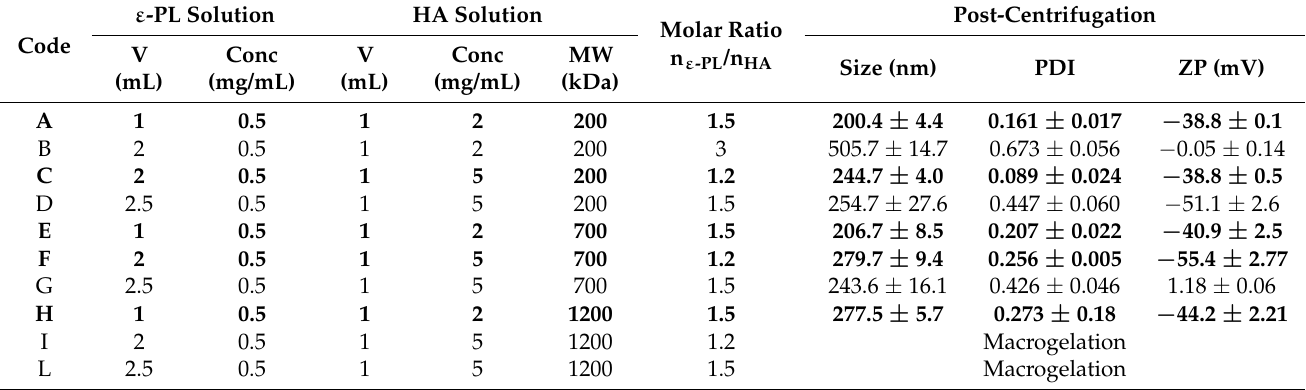
Table 1. Preliminary design of nanogels. Formulation composition and results in terms of size, PDI and ZP after crosslinking with ε -PL (n = 3, analysis in triplicate for single